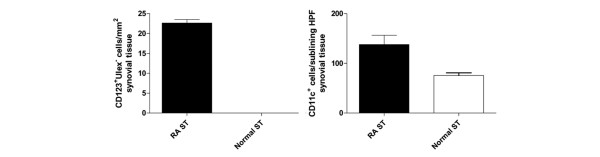
CD123+ dendritic cells (DCs) and CD11c+ cells are enriched in rheumatoid arthritis (RA) synovial tissue (ST). CD123+ DCs were quantitated by counting the number of CD123+Ulex- cells in sections double-stained with CD123 and Ulex. Cells were counted in each of the entire sections from three patients and three normal controls at high power, and for each biopsy this number was corrected for the area of the section to obtain the number/mm2. To quantitate CD11c+ cellular infiltration, the number of CD11c+ cells was counted in three high-power fields of the synovial sublining in sections from three patients and three normal controls. Data represent means ± standard error of the mean.